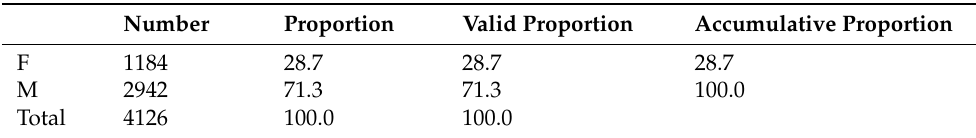
Table 4. Sex characteristics of the